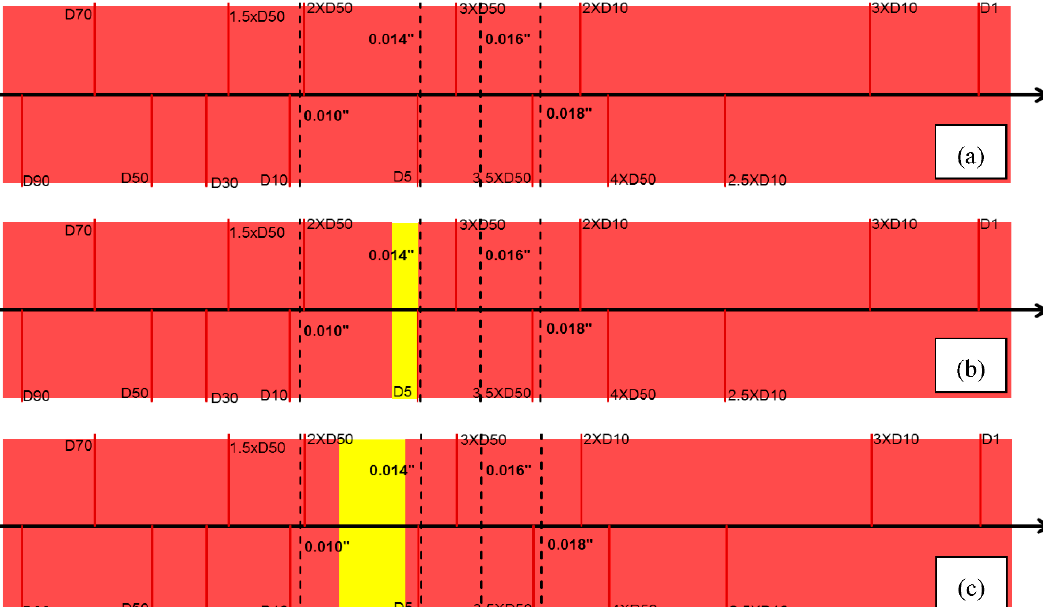
Figure 13. TLS of DC ‐ II in the normal condition for SPF 120 ( a ), SPF 168 ( b ), and SPF 216 ( c ).